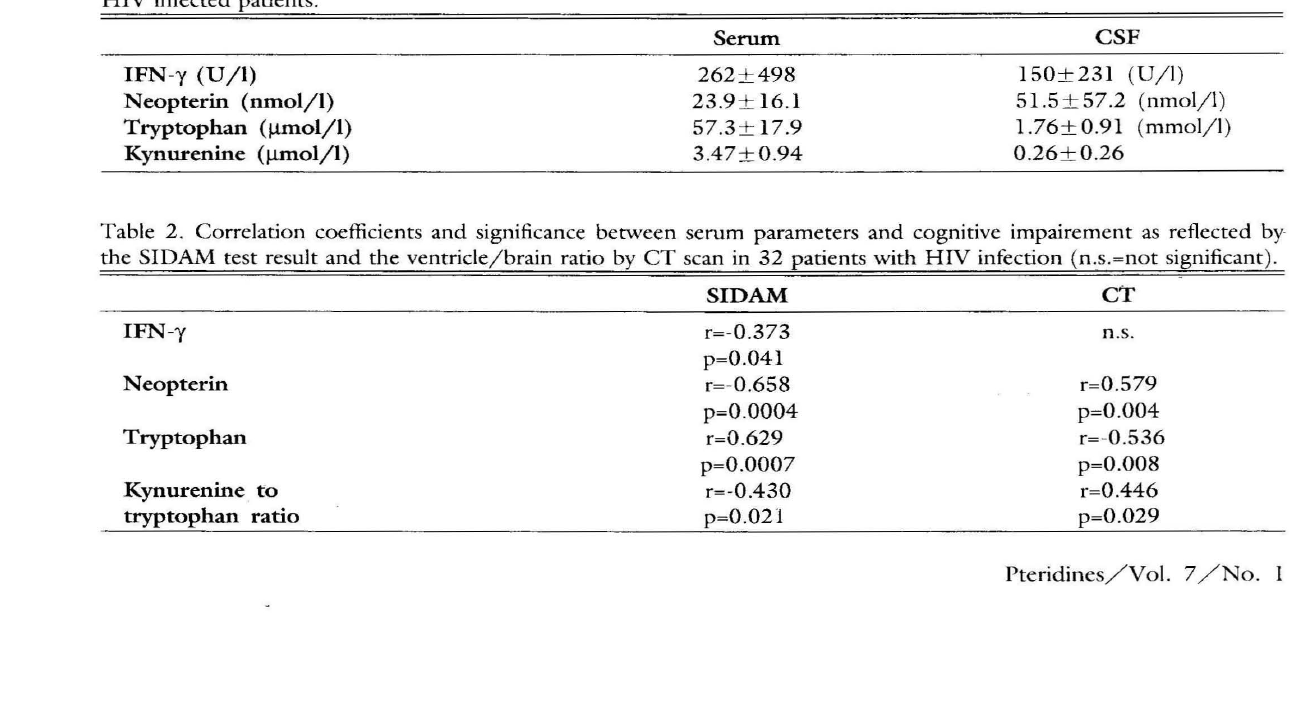
Table 1. Values (mean±S.D.) of IFN-y, neopterin, tryptophan and kynurenine in serum (n=32) and CSF (n=23) of HIV infected patients.